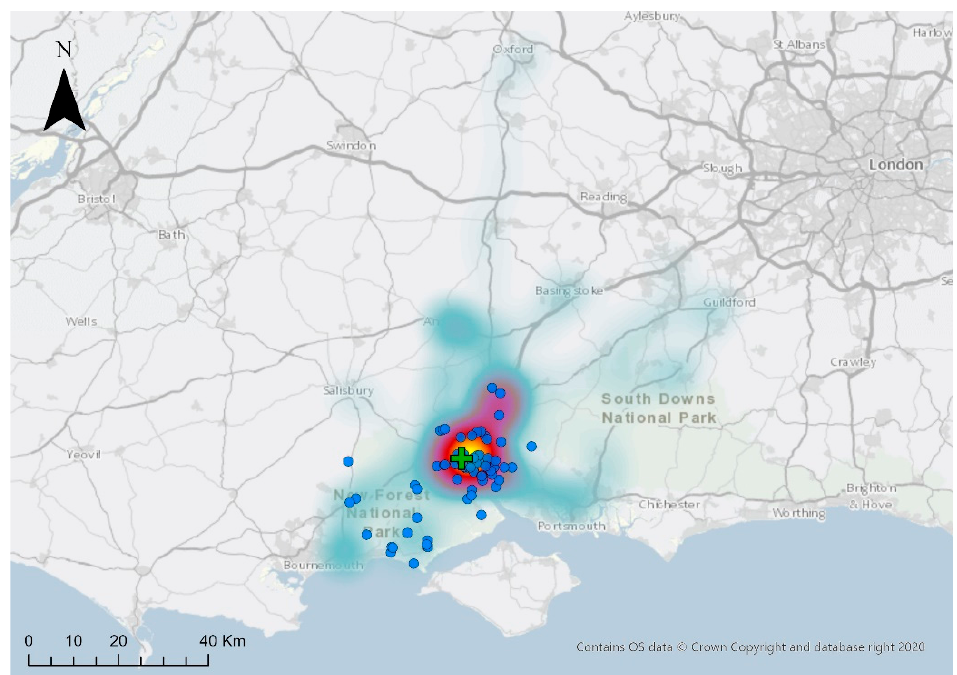
Figure 7. Map showing movements of one example PTS vehicle during all weekdays in March 2021 in the BAU scenario. Heat map shows intensity of vehicle movements, blue circles show locations of GP surgeries and green cross shows the location of SGH.